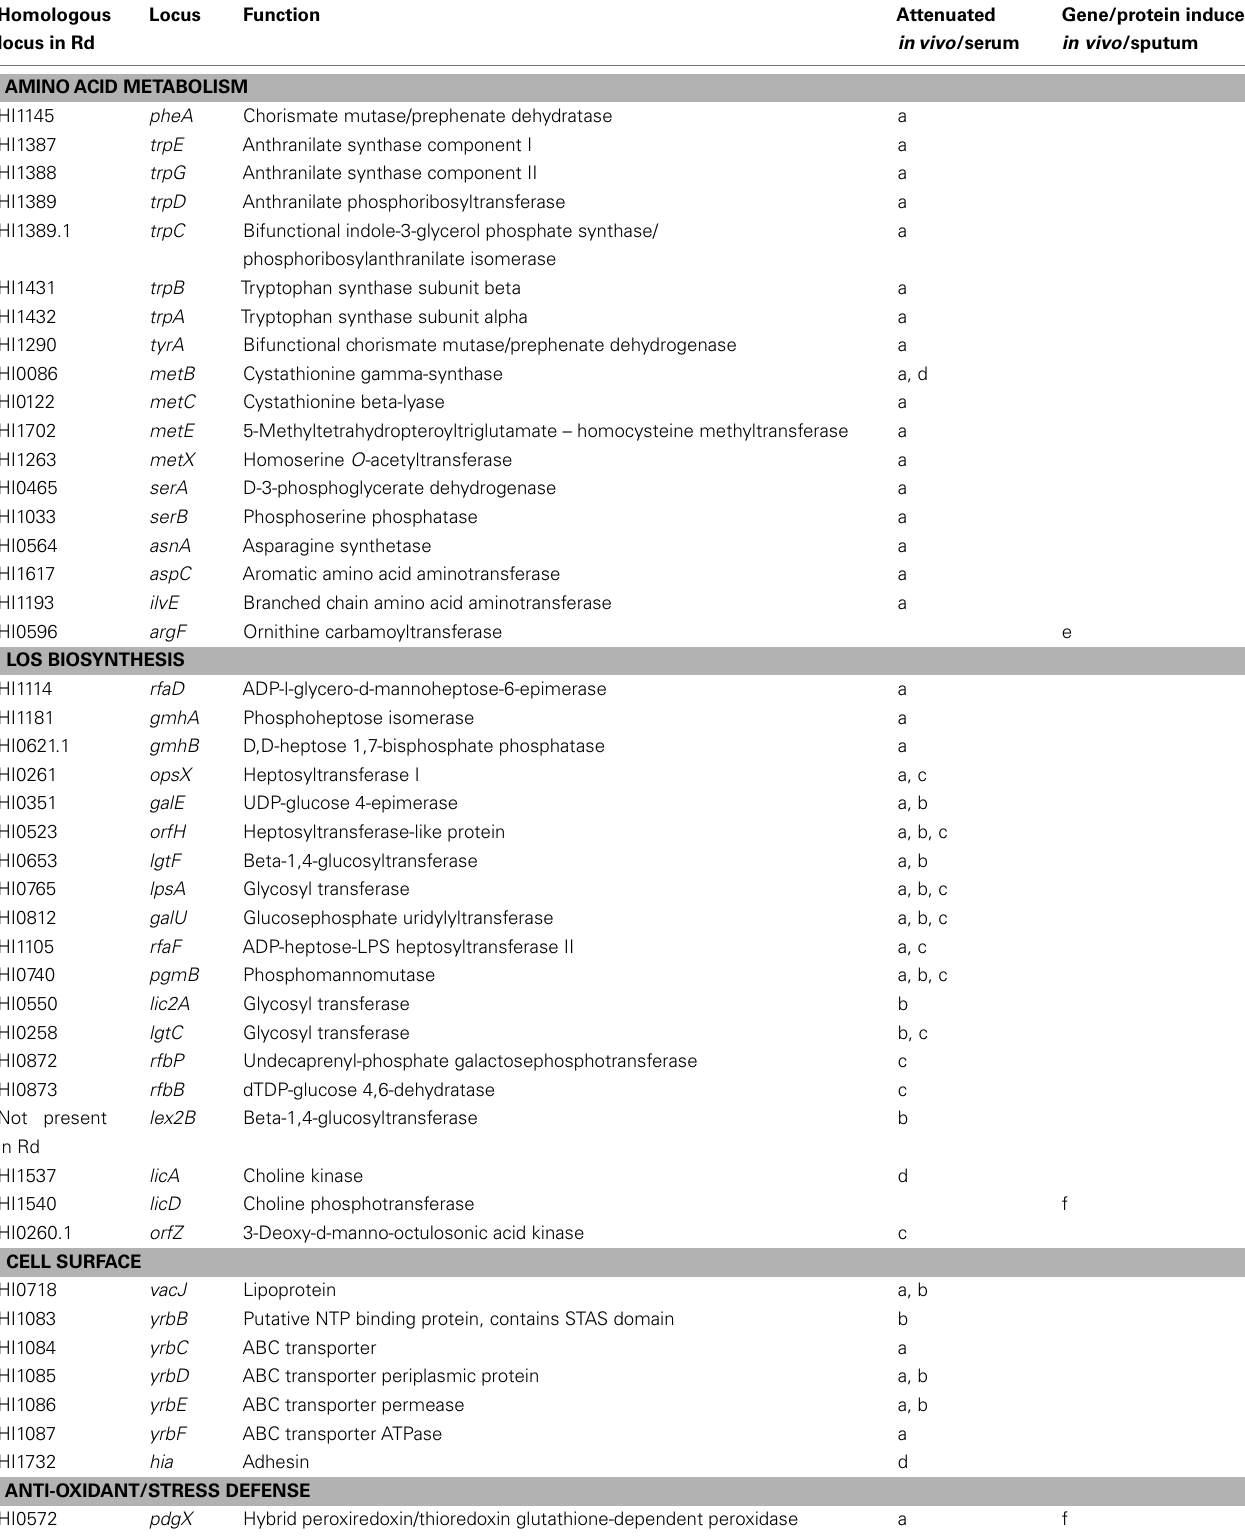
Table 1 | Haemophilus influenzae genes involved in pathogenesis. Homologous Locus Function Attenuated locus in Rd